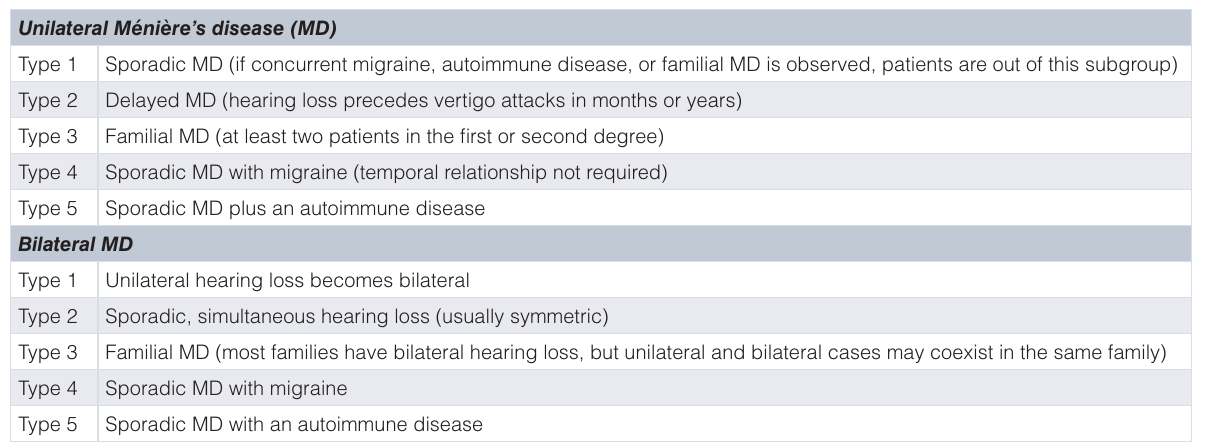
Table 2. Clinical subgroups of patients with unilateral and bilateral Ménière’s disease. Unilateral Ménière’s disease